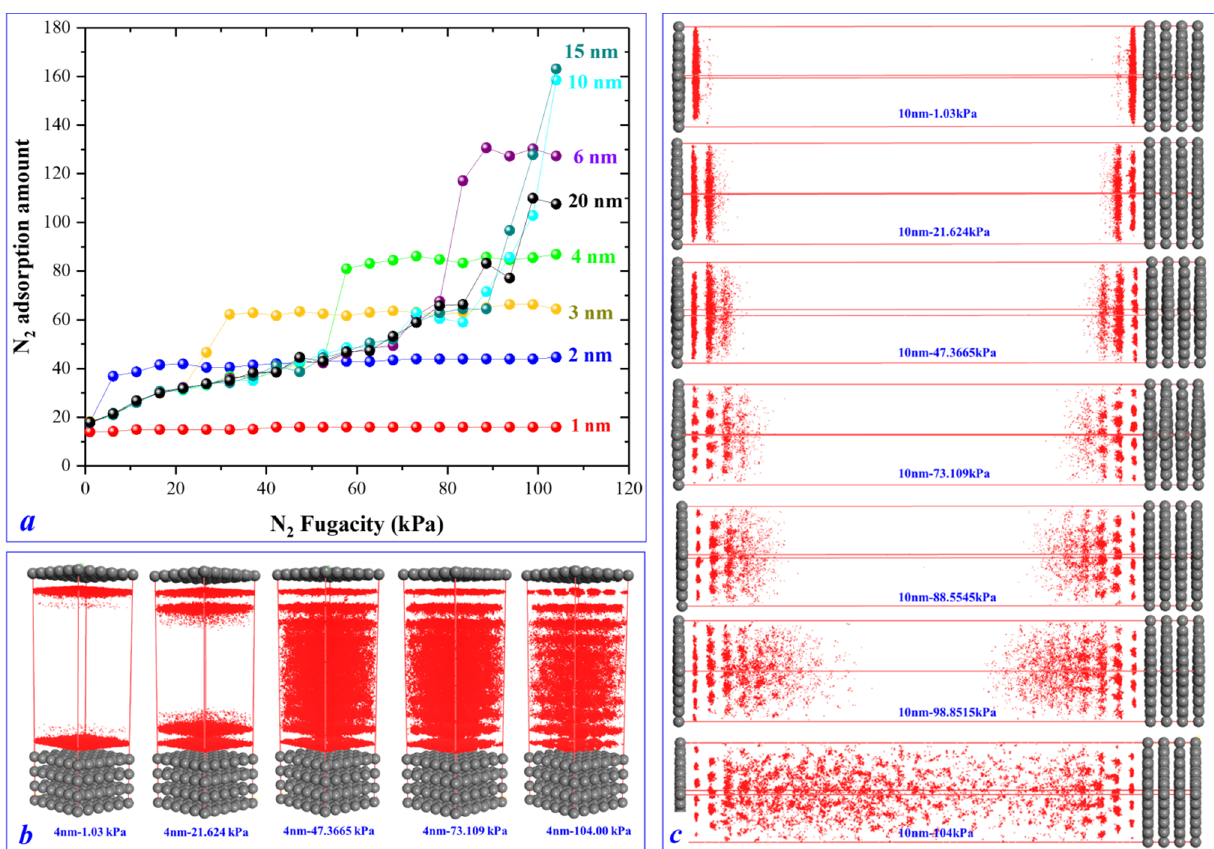
Figure 5. ( a ) N 2 adsorption isotherms in different-sized slit pores; ( b ) N 2 density distribution in the 4 nm slit pore; ( c ) N 2 density distribution in 10 nm slit pore. 4 nm slit pore; ( c ) N 2 density distribution in 10 nm slit